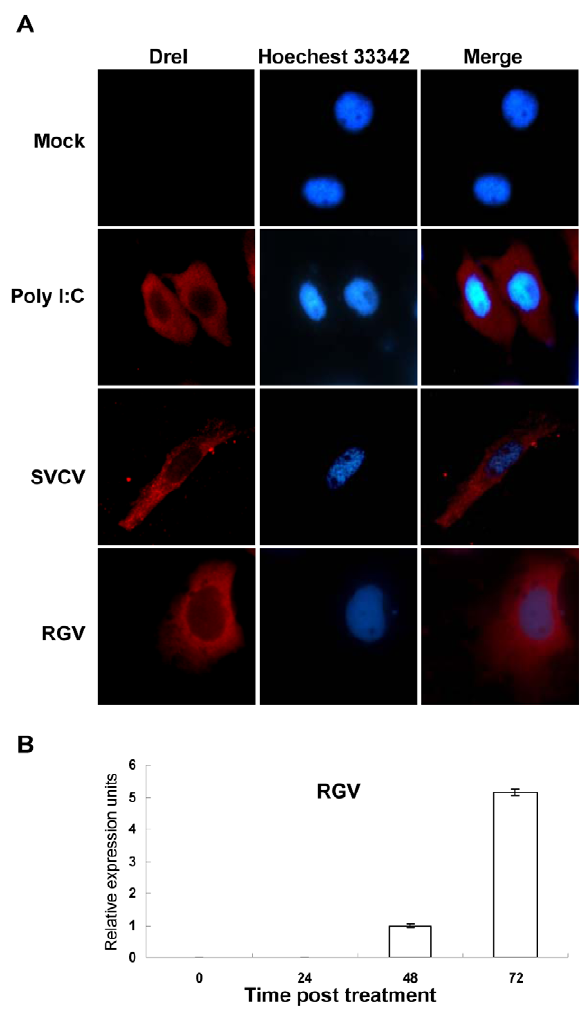
Figure 7. Immunofluorescence localization of DreI. (A) ZFL cells seeded on microscope cover glass in 6-well plates were stimulated with 2 m g poly I:C for 24 h, or infected with 10 TCID 50 of RGV or SVCV per well for 72 h, then the cells were fixed, permeabilized, and immuno- blotted with anti-DreI antiserum at 4 u C overnight. The cell monolayers were further stained with Alexa Fluor 546 anti-rabbit antibody and Hoechest 33342, then examined using a Leica DM IRB fluorescence microscope. Mock-infected ZFL cells were used as a control. The red staining represented DreI protein signal and the blue indicated nucleus region. Magnification 100 (oilimmersion objective). (B) ZFL cells were infected with RGV at a dose of 10 TCID 50 and were sampled at the indicated times. The relative transcript level of DreI was detected by real-time PCR and normalized to the expression of b -actin . Error bars represent SDs obtained by measuring each sample in